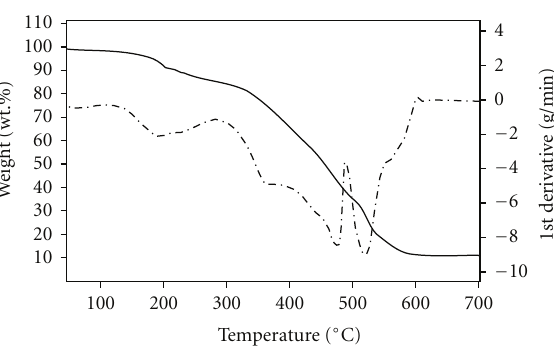
coordination of metal ions to C = N and C = O groups [36–38].